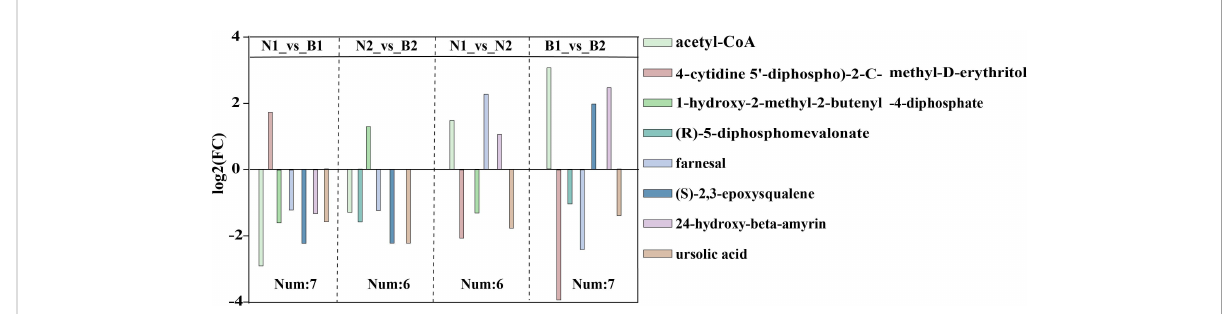
FIGURE 3 The differentially accumulated metabolites (DAMs) in the N1_ vs _B1, N2_ vs _B2, N1_ vs _N2, and B1_ vs _B2 comparison groups. Different colors in the legend indicate different types of DAMs. The ordinate indicates the abs (log2FC), and the number indicates the number of DAMs in the above four comparison groups. Rectangular squares represent the different comparison